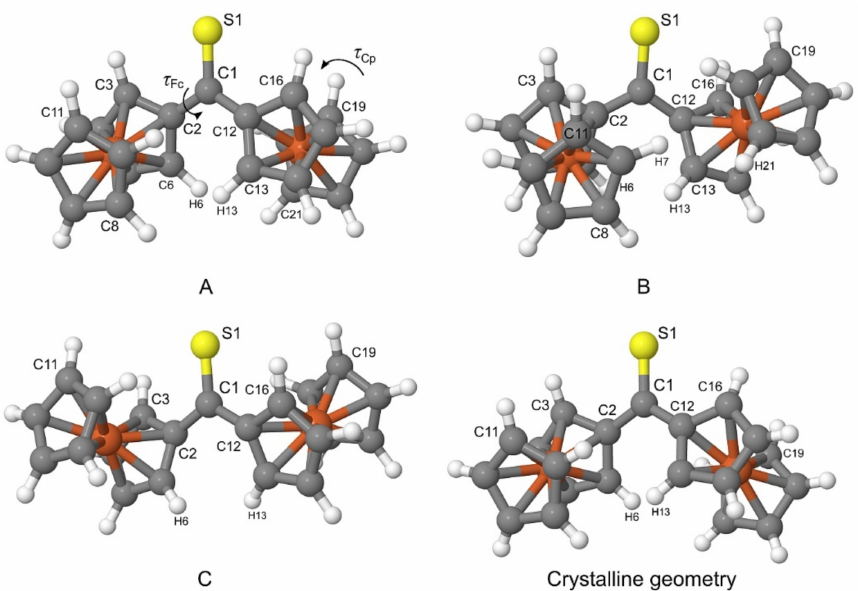
Figure 4. Optimized geometries of three Fc 2 CS rotamers ( A – C ) and the XRD molecular geometry of Fc 2 CS. Colors coding individual elements and numbering of selected atoms are the same as in Figure 1 (a version of the present figure with all atoms numbered can be found in the Supplementary Materials, Figure S2). Table 5. Selected geometrical ( τ Fc , τ Cp , in ◦ ), energetic ( ∆ E , ∆ E + ∆ ZPVE, in kcal mol − 1 ) and electric ( µ , in D) parameters for three rotamers of an isolated Fc 2 CS molecule.